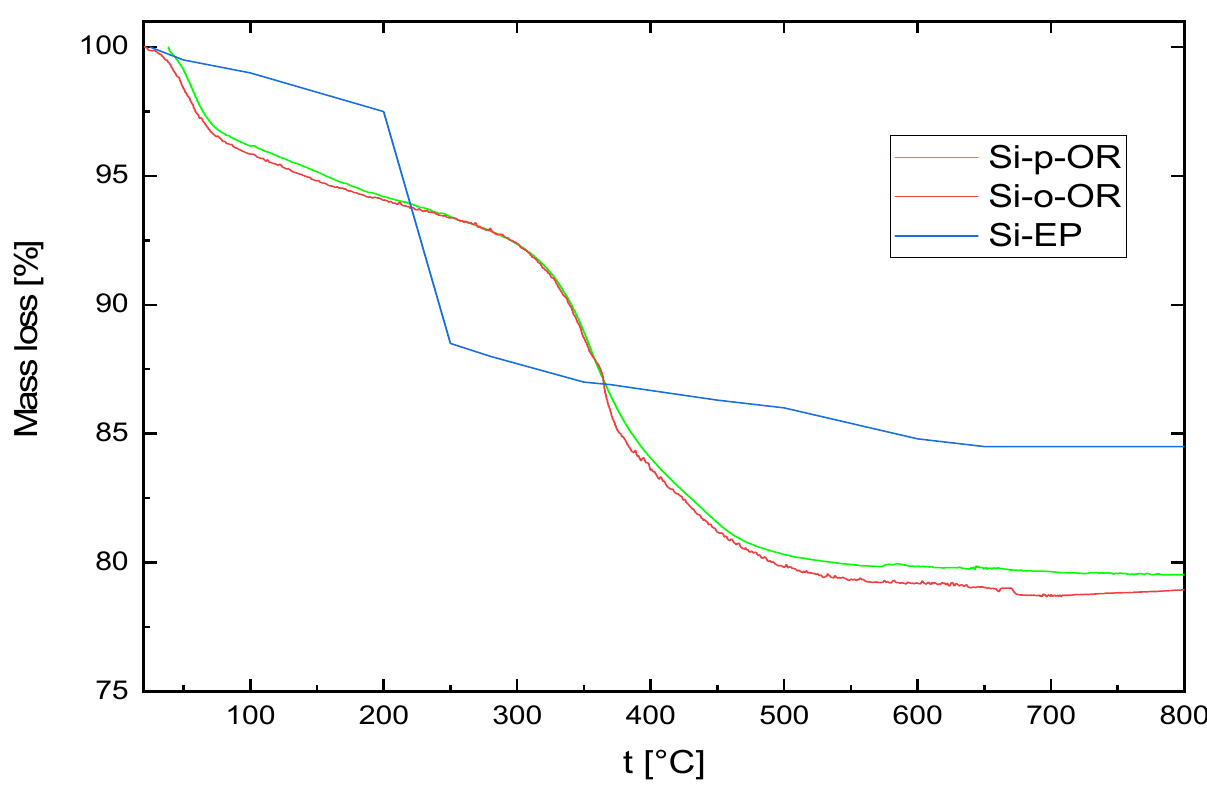
Figure 3. Thermogravimetric profiles of Si-EP , Si-o-OR and Si-p-OR. The N 2 adsorption-desorption isotherms and the corresponding BJH pore size dis- tribution of SiEP , Si-o-OR and Si-p-OR were investigated. Figure 4 shows a type IV isotherm with a visible hysteresis loop, indicating an H2-type profile (IUPAC) and a uni- form pore diameter distribution in the mesoporous region [29]. The BET surface area,